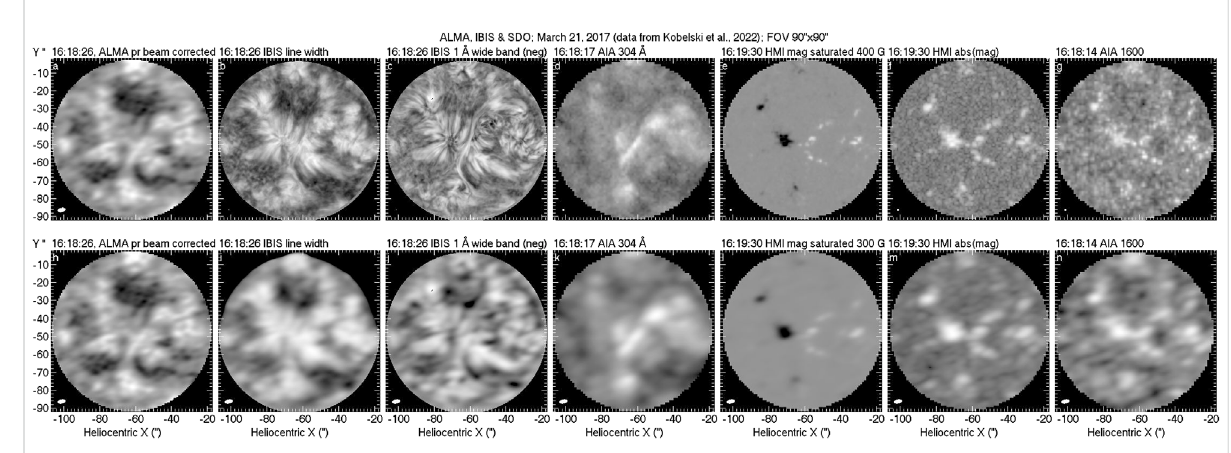
FIGURE 14 ALMA images at 3 mm. Top row: ALMA image together with IBIS H α images and SDO images; the insert at the lower left corner shows the instrumental resolution (beam). Bottom row: Same as in the upper row, with theimagessmoothed to theALMA resolution. Produced by theauthors using data from Kobelski et al. (2022) and